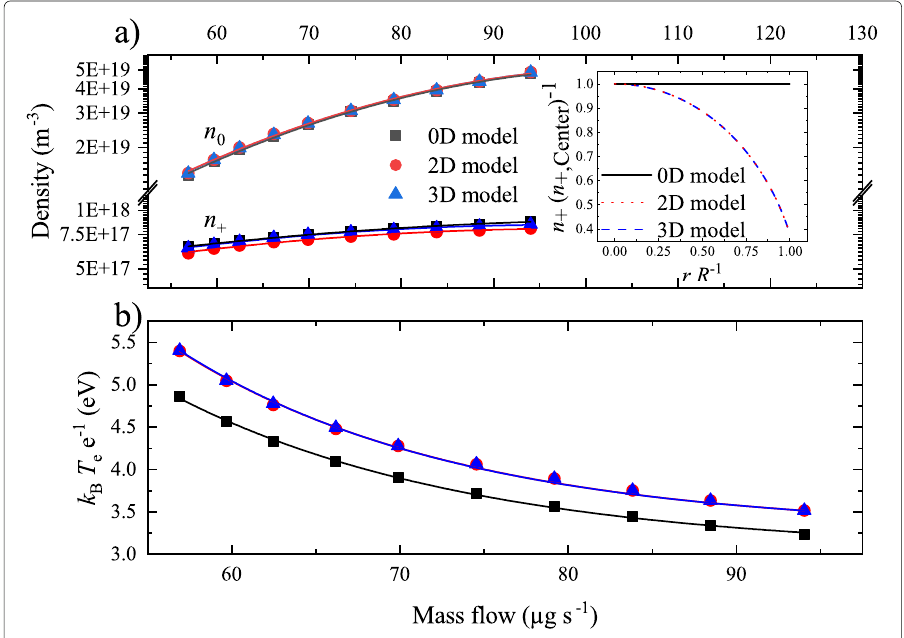
Fig. 12 Plasma parameters calculated by the three models: a ) Neutral gas density n 0 , and bulk electron density n + in the center of the discharge as function of the injected mass flow and b ) electron energy k B T e / e . While the electron density determined by the 0D model is assumed to be radially homogeneous, for both the 2D and 3D model, the electron density profile is maximal in the center of the discharge, as shown by the